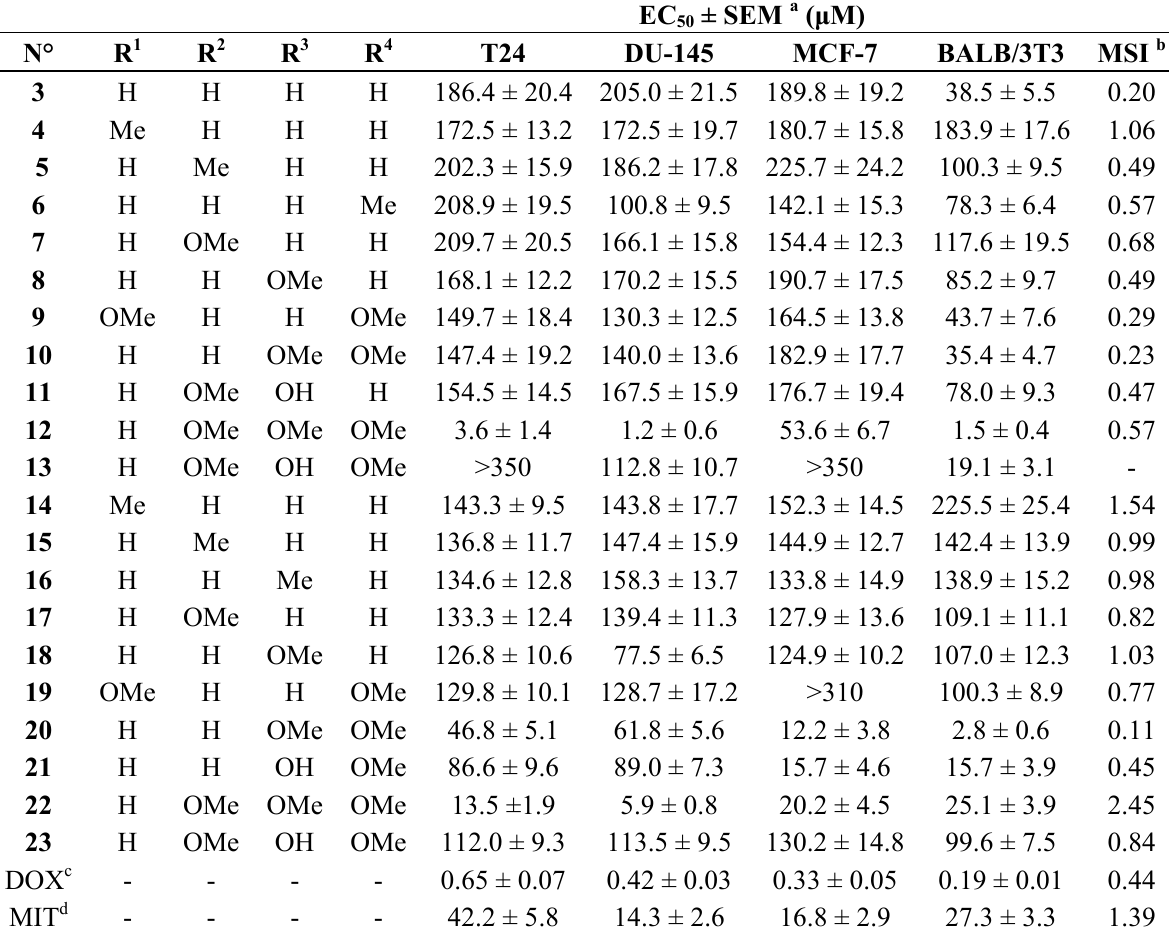
values fibroblasts/EC Index = EC 50